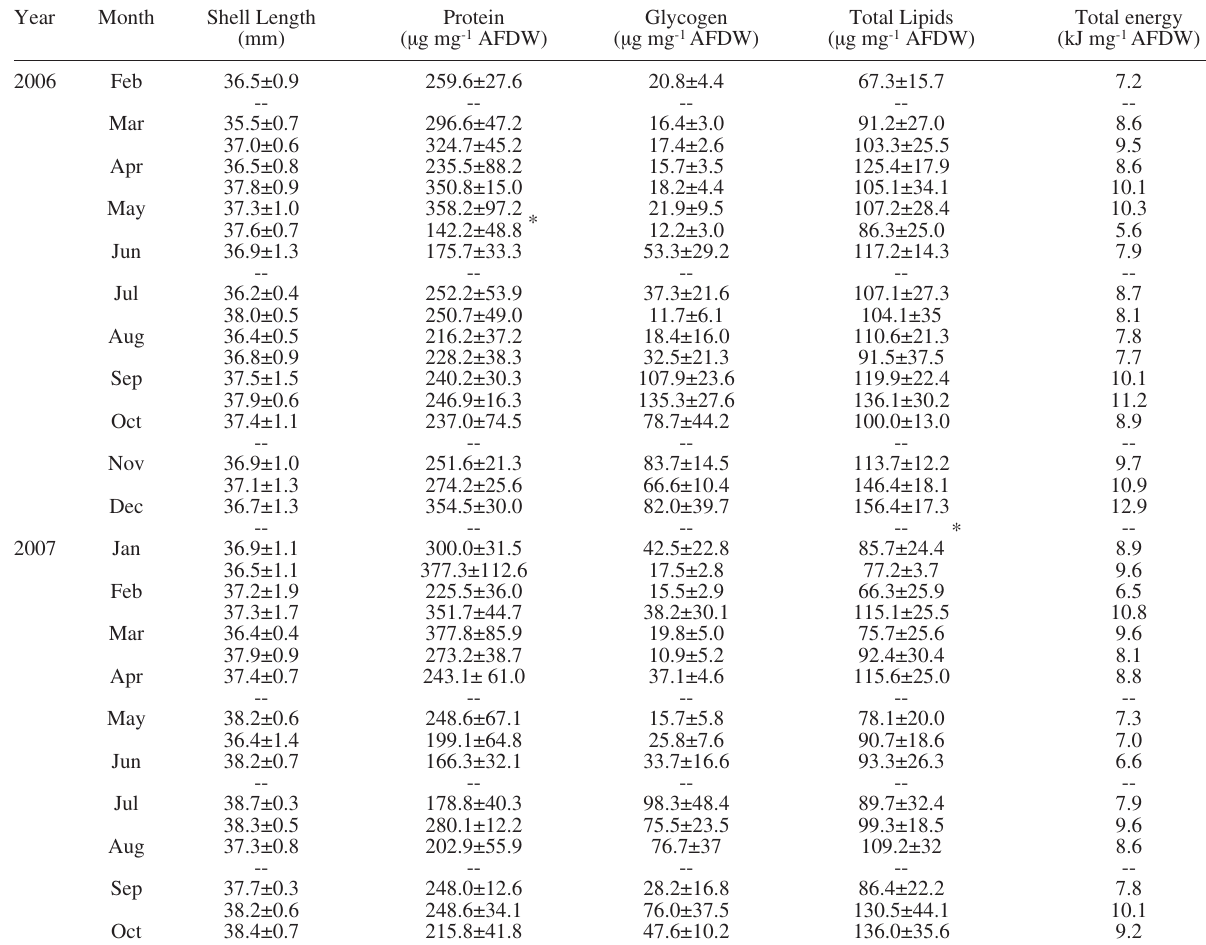
Table 2. – Mean values (±sd) of shell length (mm), proteins, glycogen, total lipids (μg mg -1 AFDW) and total energy (kJ g -1 AFDW) of V. senegalensis during the experimental period (* statistically significant differences, P <0.05 found between consecutive